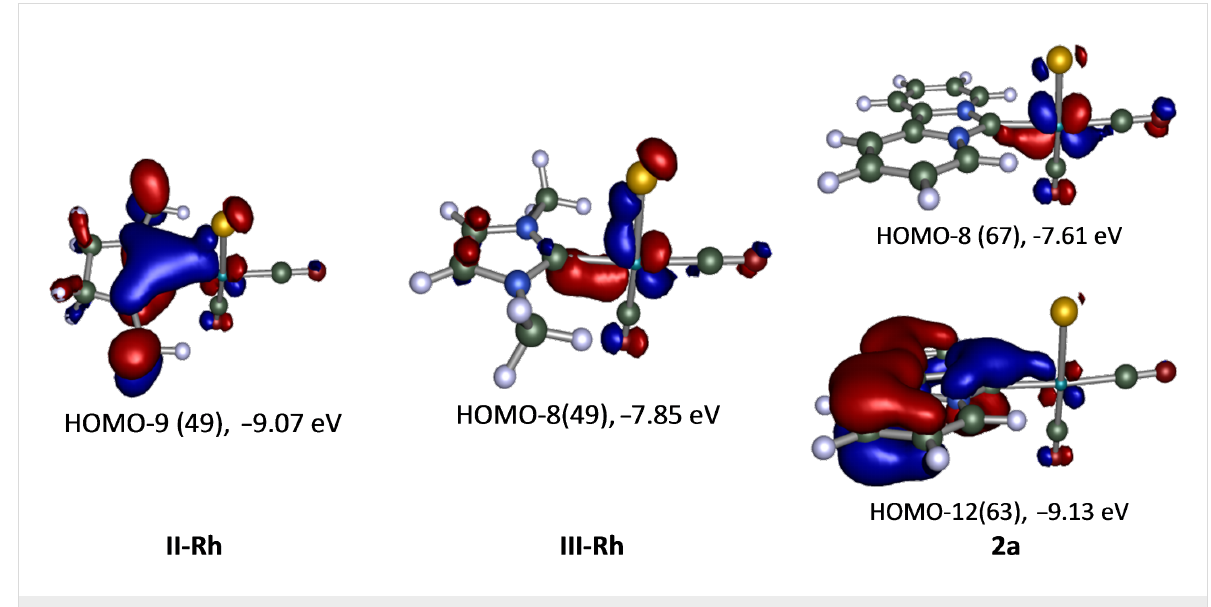
Figure 5: Molecular orbitals of the Rh complexes II-Rh , III-Rh and 2a that show ligand-metal π -bonds.